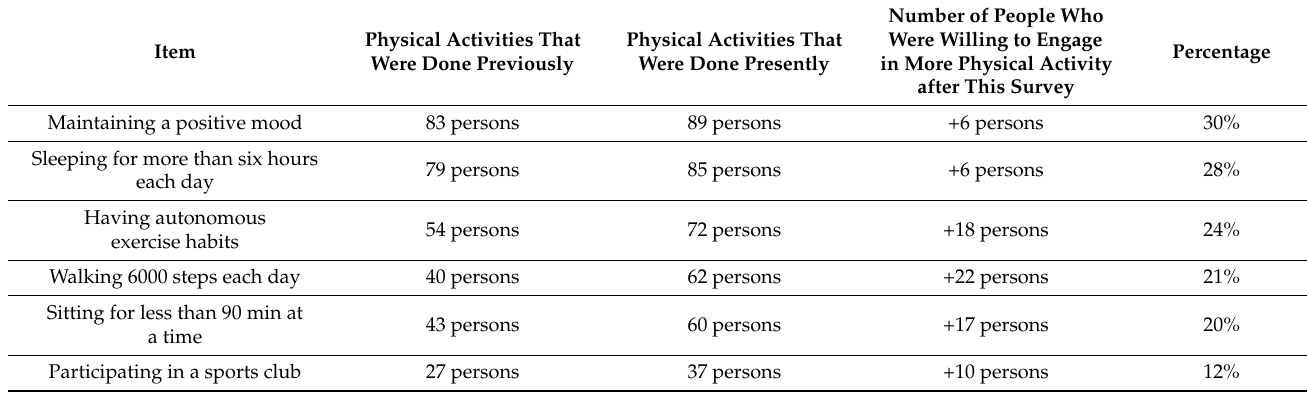
Table 5. Comparison of physical activity done previously and